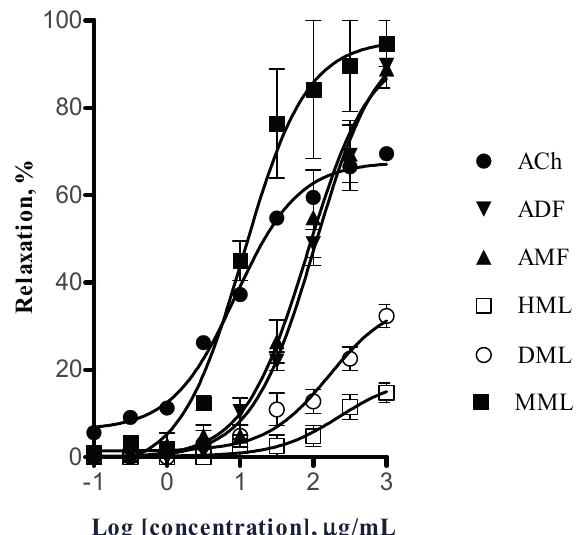
Figure 1. Concentration-response curves of the extracts obtained from the leaves and fruits of C. gracilior and ACh on isolated rat aorta rings precontracted with phenylephrine (PE) (1 µM). ACh = acetylcholine; ADF = aqueous decoction of the fruits; AMF = aqueous maceration of the fruits; HML = hexane maceration of the leaves; DML = dichloromethane maceration of the leaves; MML = Methanol maceration of the